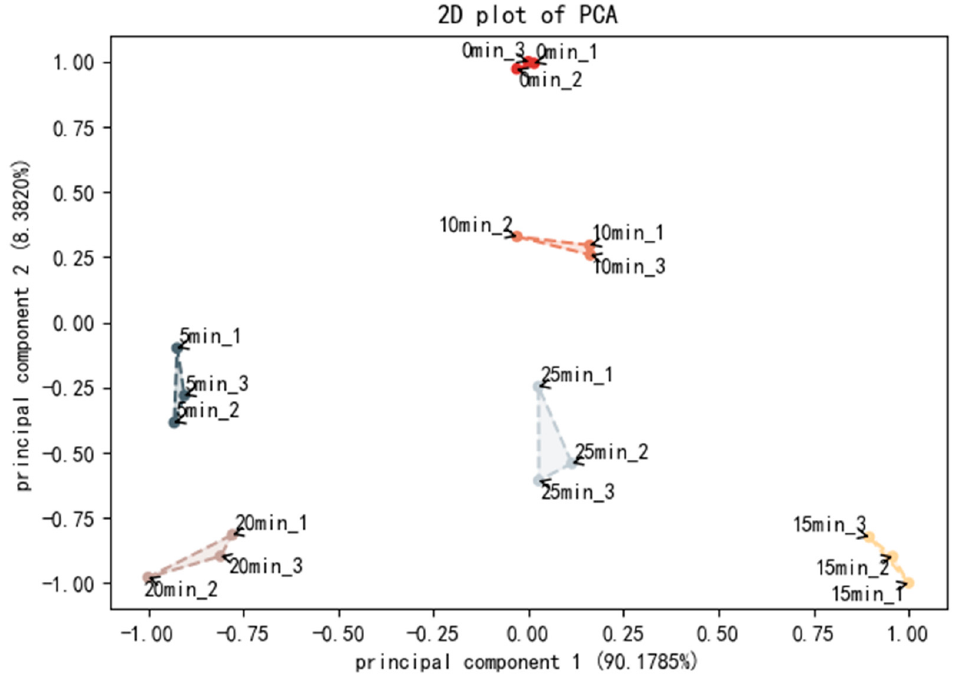
Figure 2. The PCA plot of electronic tongue data of swimming crab steamed at different